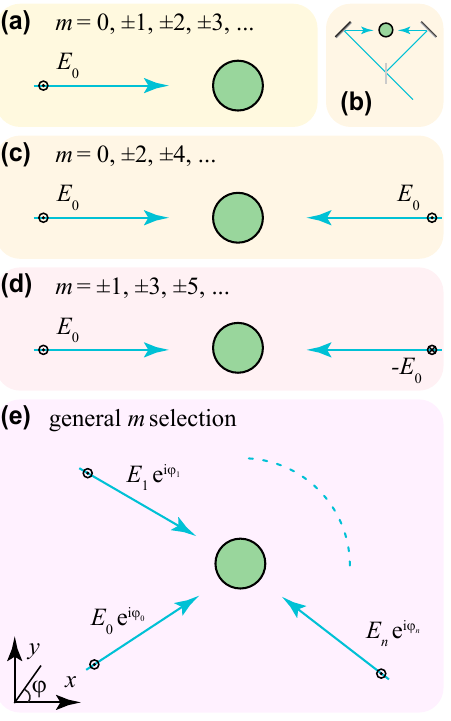
Figure 3: Mode selection through light interference. A single incident light plane wave (a) contains all possible values of the azimuthal number m in the external field, and can thus excite all available SPDC channels for the chosen input frequency. We can combine illumination from different directions through beam splitters and mirrors, as indicated in (b) for two-plane-wave irradiation, leading to a selection of the m values from the external light. Examples of selection by irradiation with two in-phase and out-of-phase counter-propagating plane waves are shown in (c) and (d). More stringent selection of m is possible by combining multiple along different azimuthal directions plane waves of amplitudes E j 𝜑 , with j = 0 , … , n j